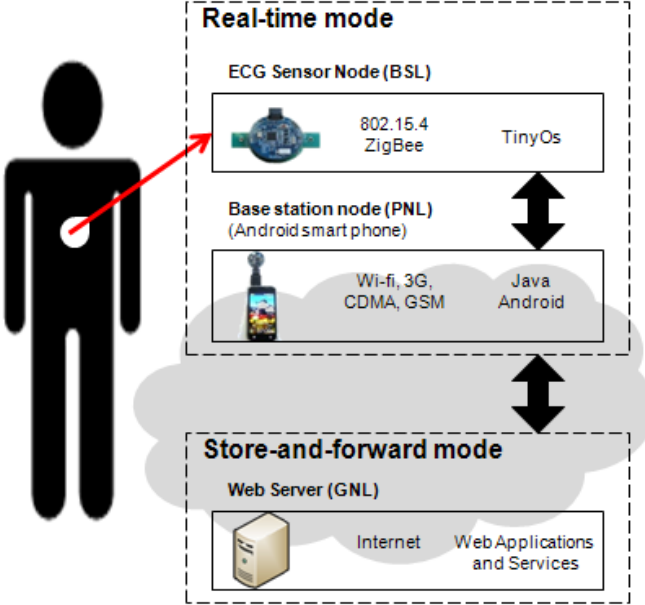
Figure 1. System design of real time ECG monitoring and analyzing on an Android™ mobile